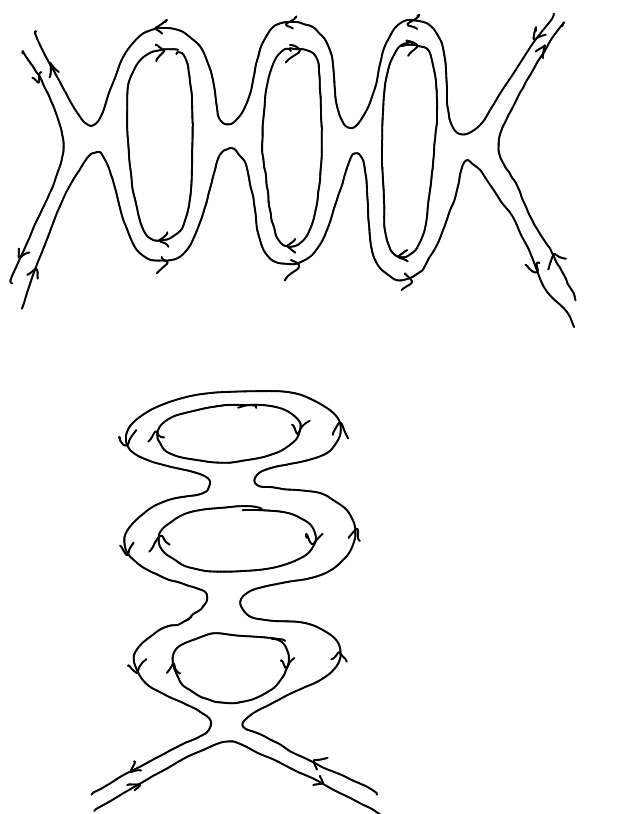
Figure 1 . A typical diagram that violates perturbative expansion in powers λ t in ’t Hooft’s double line notations. Each extra bubble brings an additional factor λ t